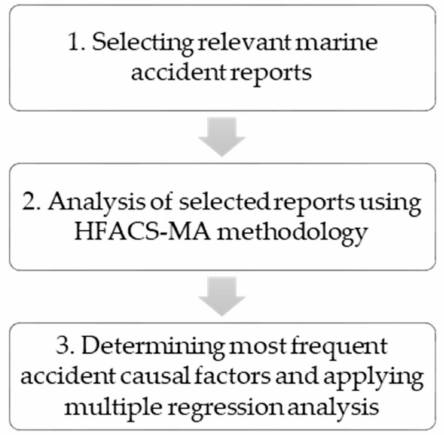
Figure 1. Research